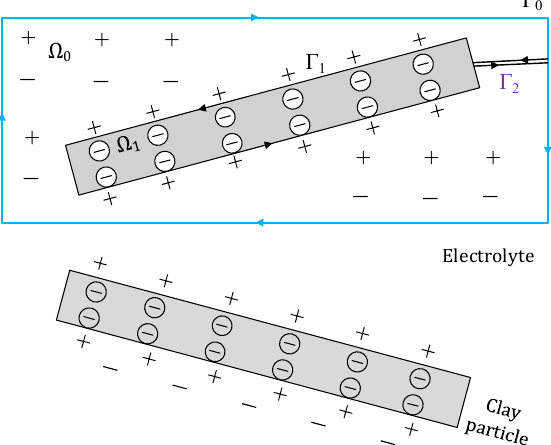
Figure 2. Two inclined finite charged clay particles in an electrolyte solution.